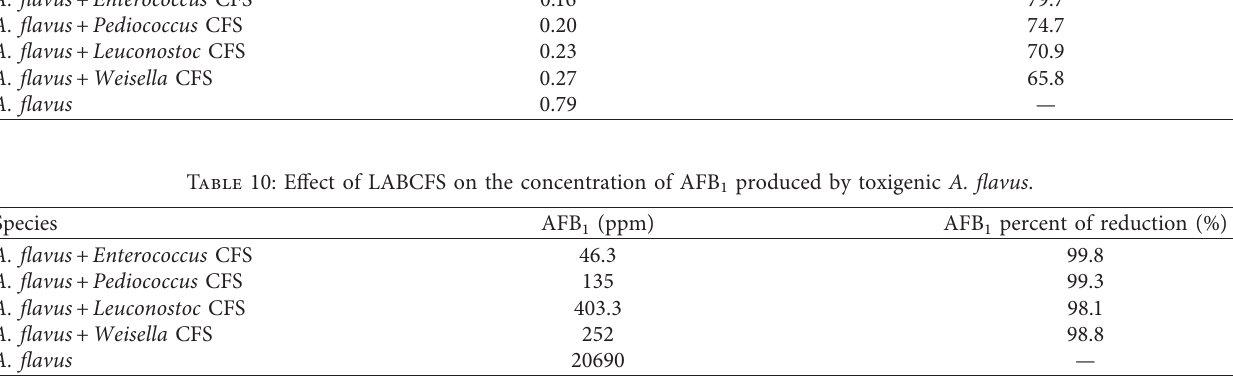
Table 9: Mycelial mass production by A. flavus in the presence of LAB.